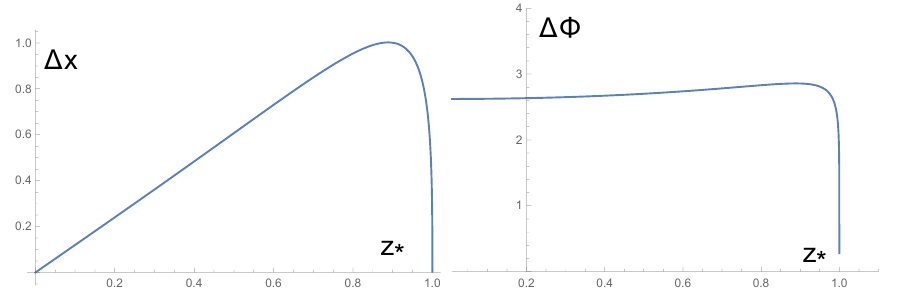
Figure 24 . The profile of the width ∆ x = 2 x ∗ (left) and the shift of scalar field ∆ φ = φ ( x ∗ ) − φ ( − x ∗ ) (right) as function of z ∗ on the EOW brane in BTZ. We set a = 1